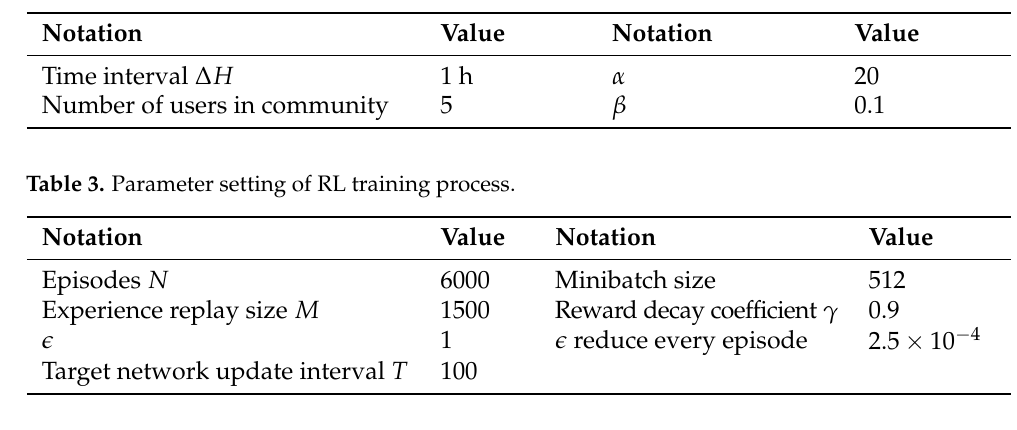
Table 2. Parameter setting of CEMS environment.